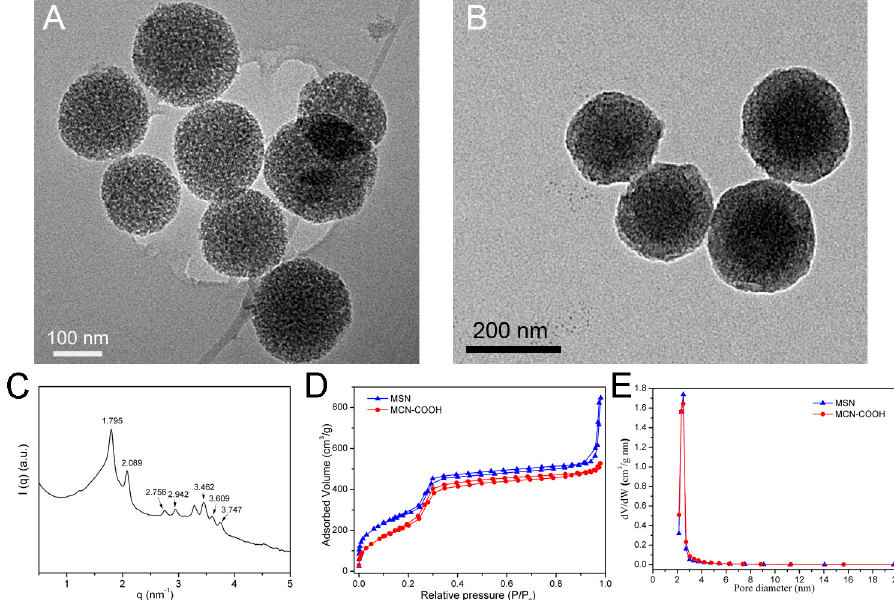
Figure 2. Transmission electron microscope (TEM) image of ( A ) MSN and ( B ) MCN-COOH; ( C ) small angle X-ray scattering (SAXS) pattern of MSN; ( D ) Nitrogen adsorption / desorption isotherms and ( E ) pore size distributions of MSN and